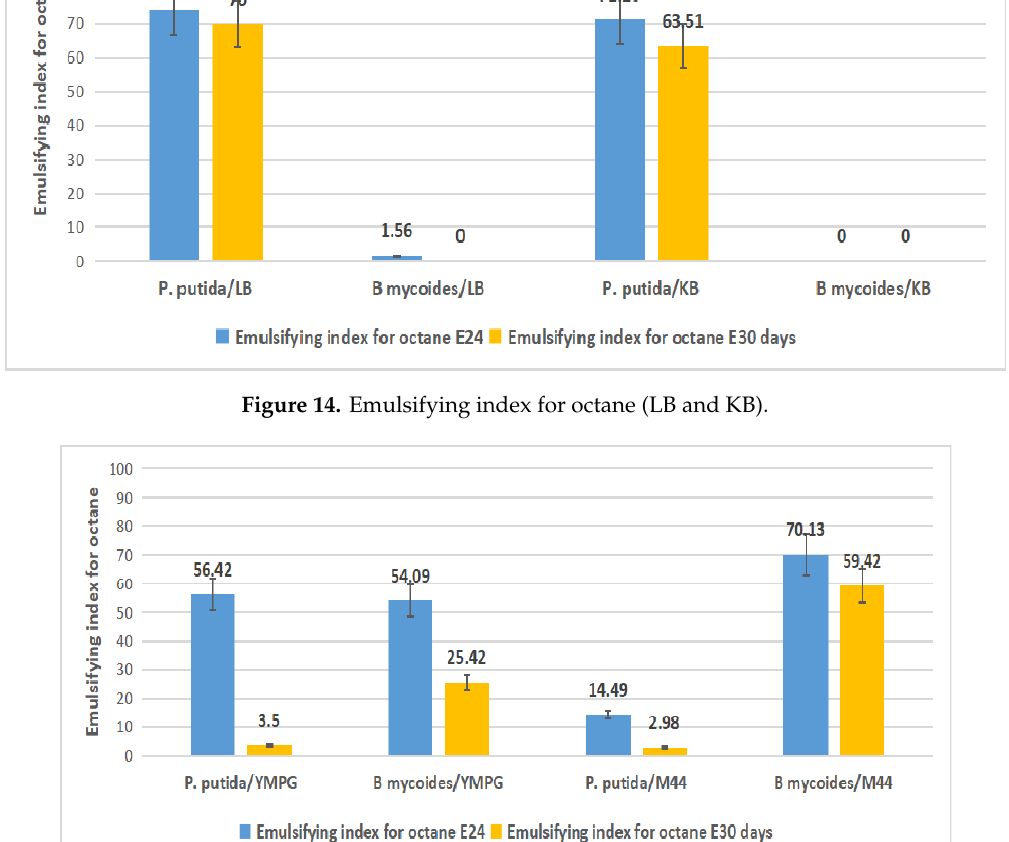
Figure 15. Emulsifying index for octane (YMPG and M44).